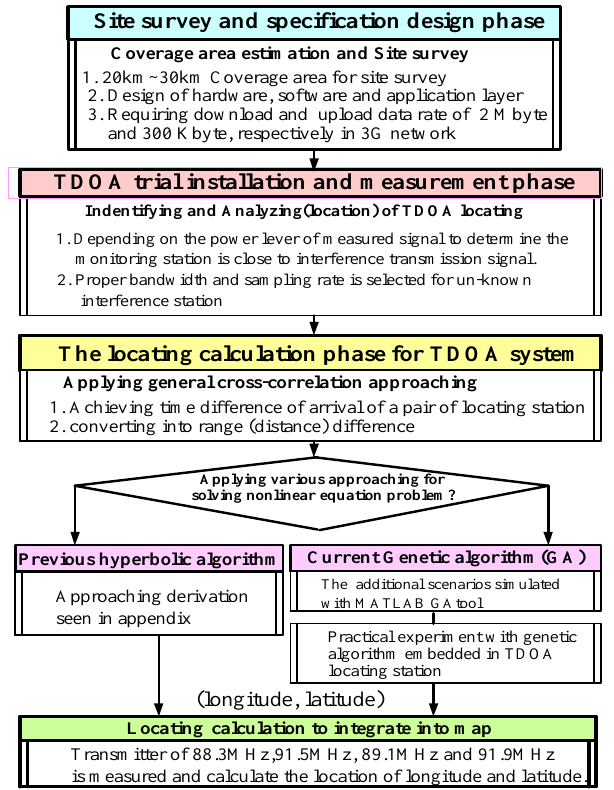
Figure 1. The major installation processing consist of below step in current proposed TDOA-based monitoring